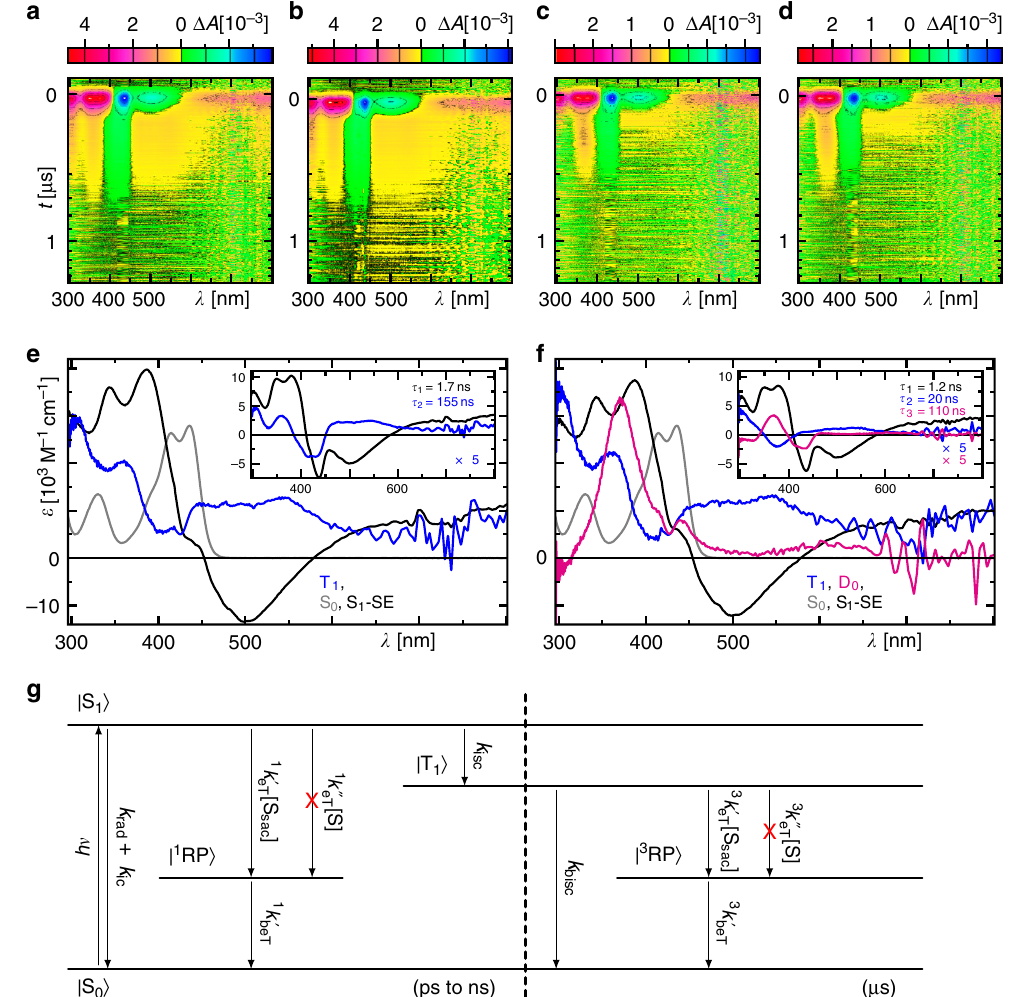
Fig. 4 Excited singlet and triplet state dynamics of 5 ox . a – d False colour representation of the time-resolved absorption spectra of 5 ox (60 μ M) in non- degassed ACN in the absence ( a ) or presence of either 50 mM p -BA ( b ), 50 mM DIPEA ( c ), or both 50 mM p -BA and 50 mM DIPEA ( d ) exciting at λ exc = 430 nm. e Species-associated spectra (SAS) that contribute to the time-resolved absorption signals in a – b , which were generated by applying the model in g to the decay-associated difference spectra (DADS) shown in the inset. f Same as e but for the data in c , d . SE stimulated emission, rad radiative, ic internal conversion, (b)eT (back) electron transfer, (b)isc (back) intersystem crossing, superscript 1/3 singlet or triplet state, RP spin correlated radical pair containing the 5 sq (D doublet state), S sac sacri fi cial electron donor, S